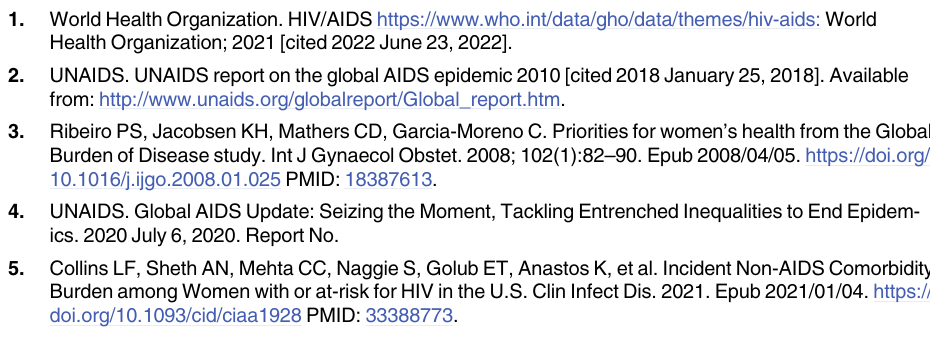
S1 Table. Power calculations for each specific aim of the Brain, Bone, Heart (BBH) study projects. S2 Table. Brain, Bone, Heart (BBH) study STROBE statement